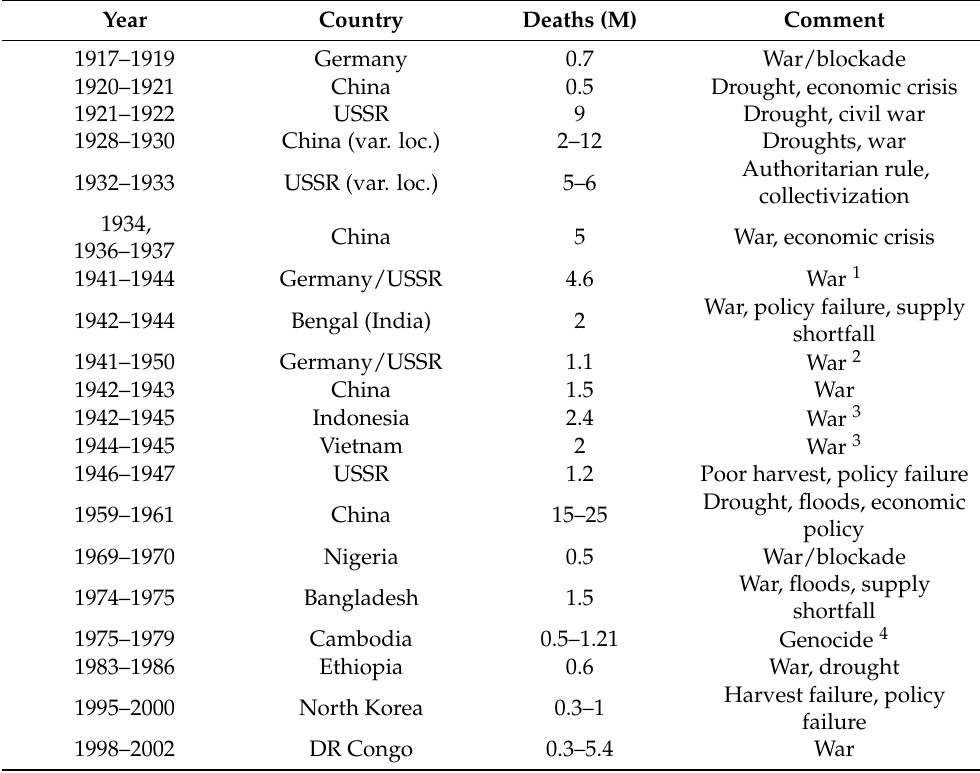
Table 1. Large-scale famines (deaths estimated at ≥ 0.5 M) in modern history, 1921–2017. Adapted and modified from [73] (pp. 22–23), [82] (pp.